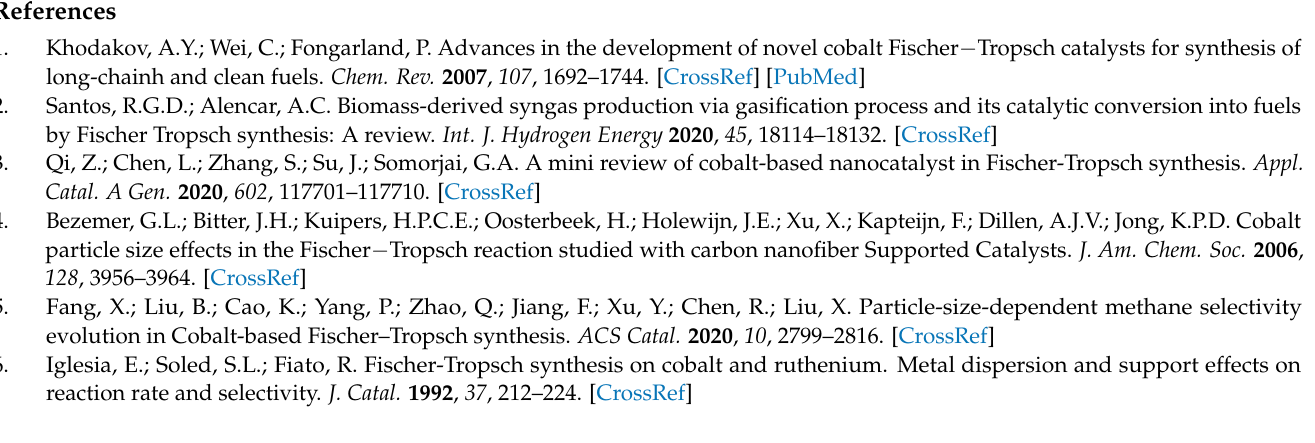
Figure S3 for CO-TPD profiles on the reference m-CoAlOx catalyst (Figure 2B), which were obtained from TCD and mass spectrometer with m/z = 28 (CO) and 44 (CO 2 ); Figure S4 for XPS spectra of Sn 3d5/2 peak on the fresh (reduced) Sn/m-CoAlOx; Figure S5 for temperature effects to product distributions (Figure 3B) on the (A) m-CoAlOx and (B) Sn(7)/m-CoAlOx; Table S1 for temperature effects to product distributions (Figure 3B) on the (A) m-CoAlOx and (B)